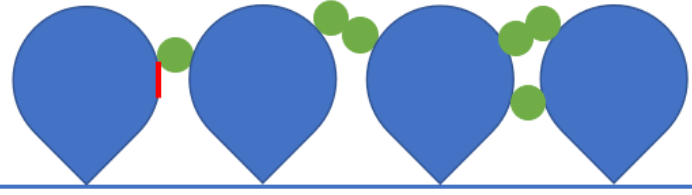
Figure 12. Drop-shaped wire profile and its interaction with particles.